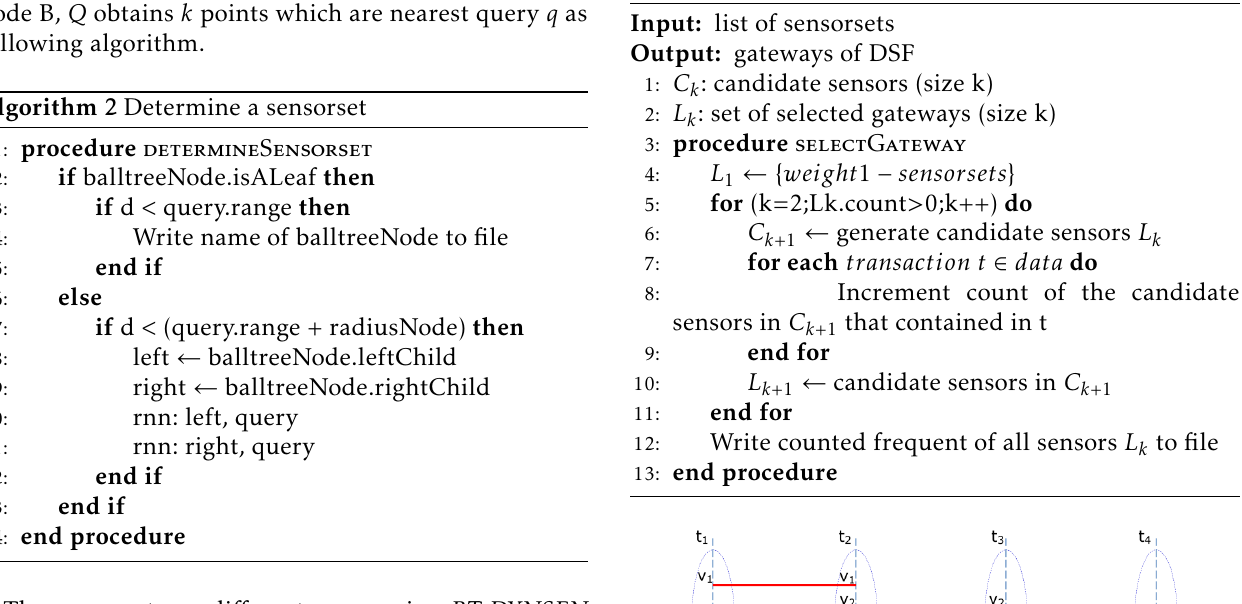
Algorithm 3 Select the gateways of a DSF